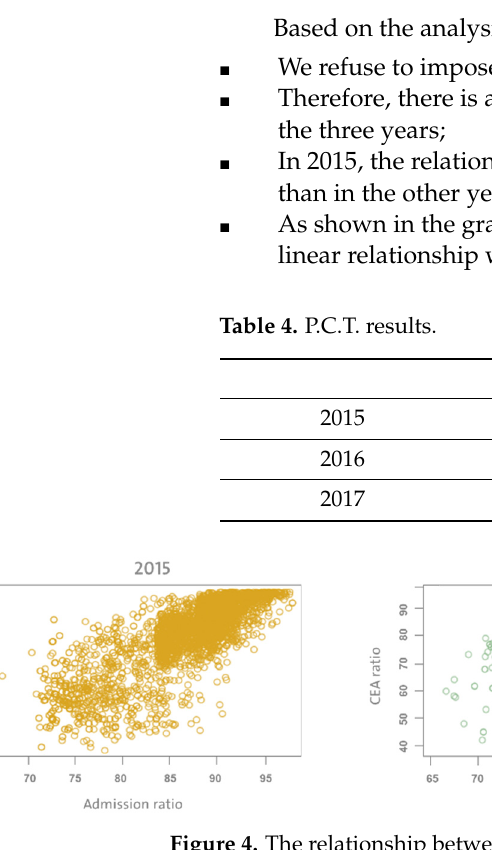
Figure 4. The relationship between the admission and CEA weighted ratios.